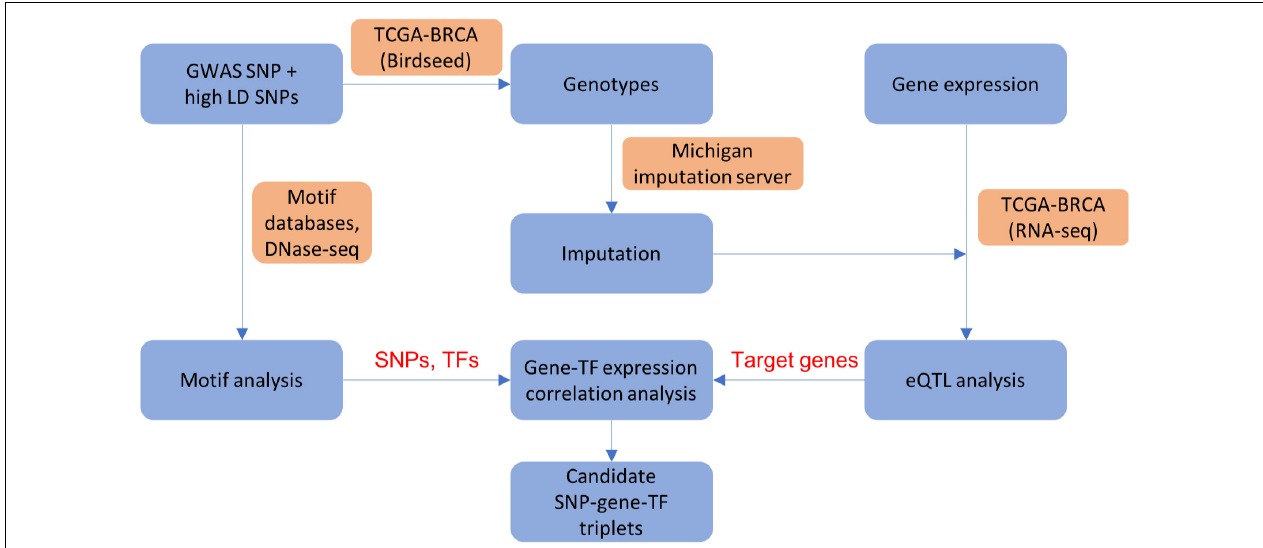
FIGURE 1 | A flowchart showing integrative analysis pipeline used in ABC-GWAS. For each GWAS locus, we perform eQTL analysis, motif analysis, and gene-TF expression correlation analysis to obtain candidate (SNP, gene, TF) triplets. Blue boxes show analysis steps, orange boxes indicate data and/or resources used in the analysis, and text in red shows intermediate